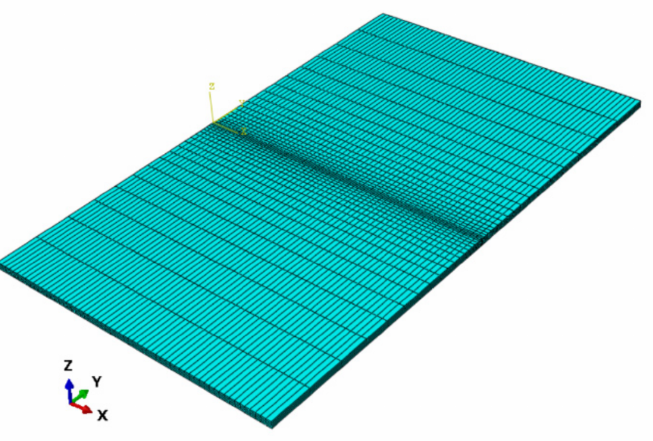
Figure 4. Three-dimensional finite element